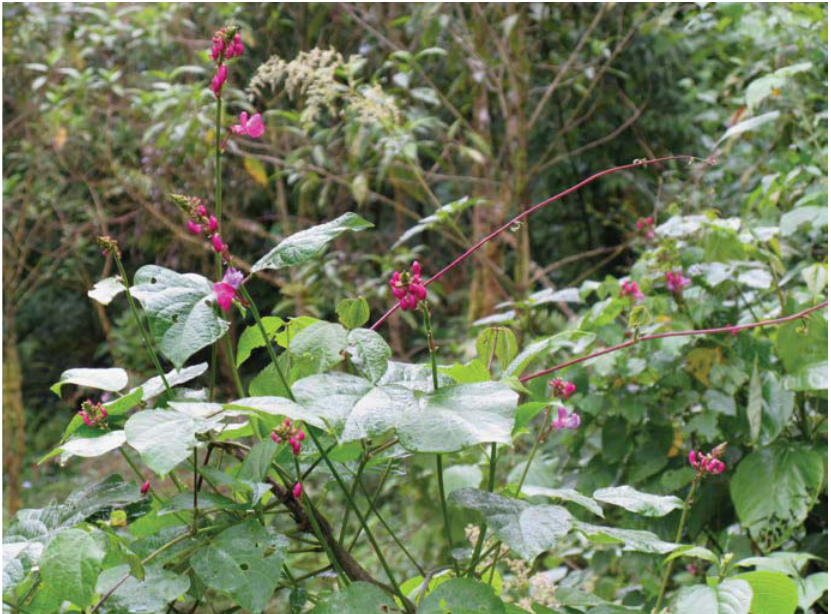
Figure 2. A population of P. costaricensis (#3246) found in the buffer zone of Chirripó national park in San José province of Costa Rica in December